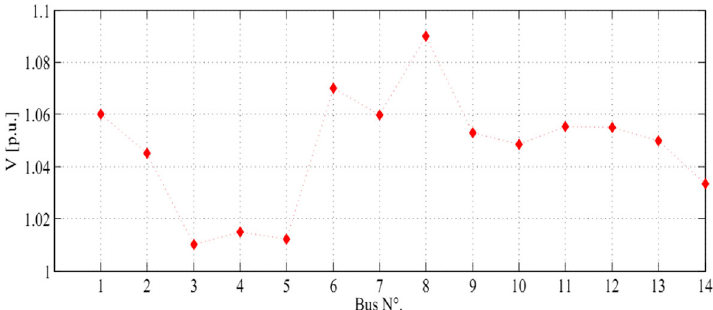
Fig. 11 Voltage profiles in the case of loss of line (1 – 2) in the IEEE 14-bu